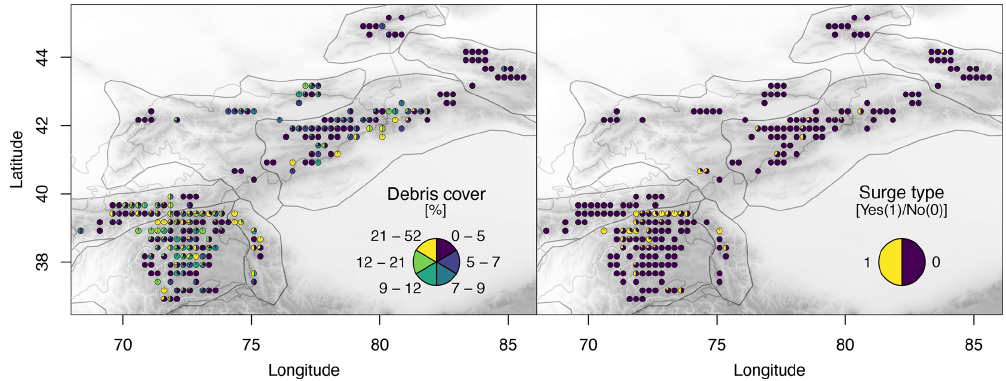
Figure A6. Surge-type glacier (Guillet et al., 2022) and debris cover (Scherler et al., 2018a) distribution in Tien Shan and Pamir.